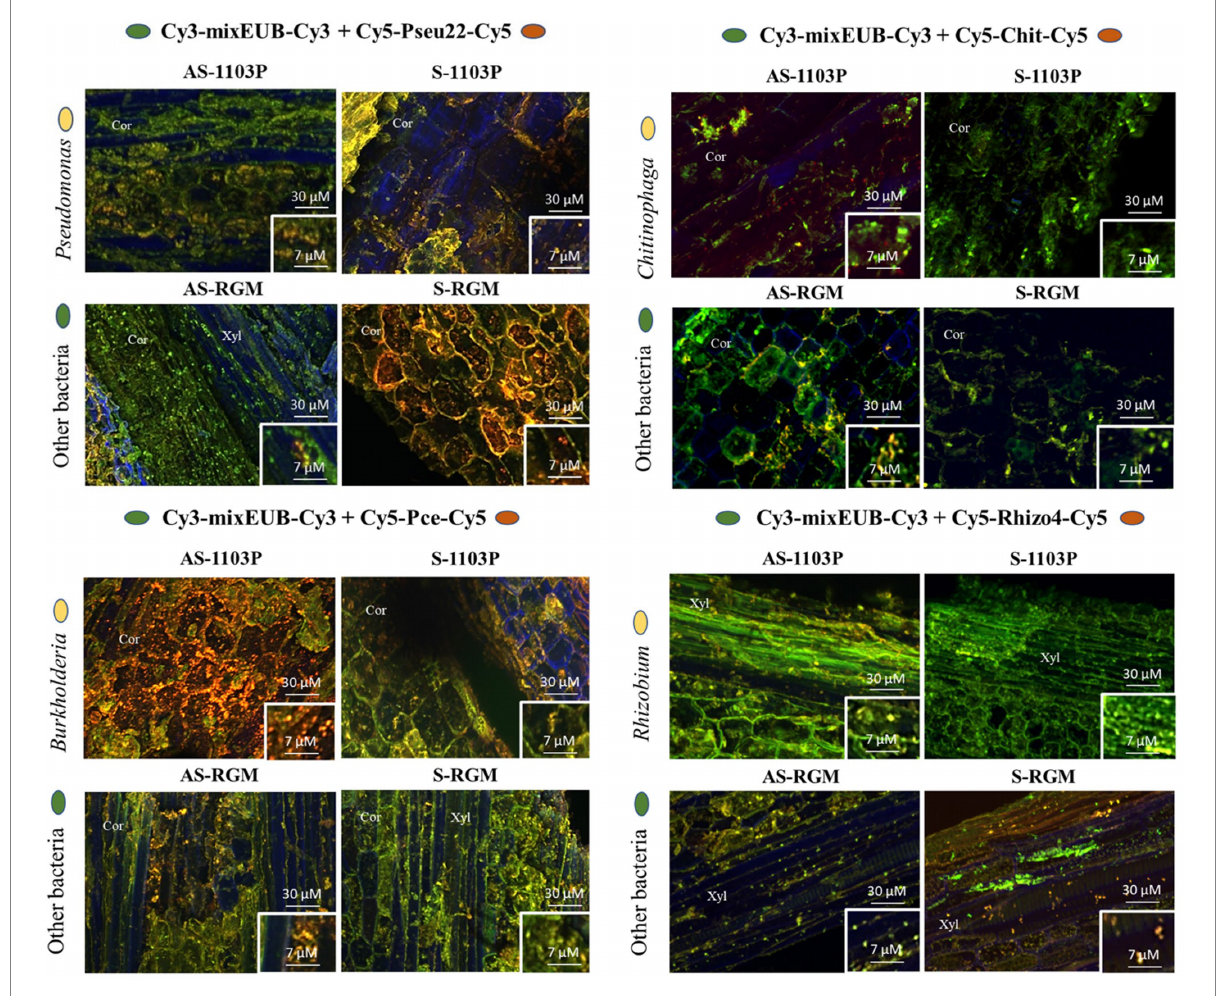
FIGURE 6 Microphotographies of the root colonization by Chitinophaga , Rhizobium , Burkholderia , and Pseudomonas genera using DOPE-FISH microscopy across the different conditions within roots sampled during the 2019 greenhouse experiment. Cor = cortex, Xyl =